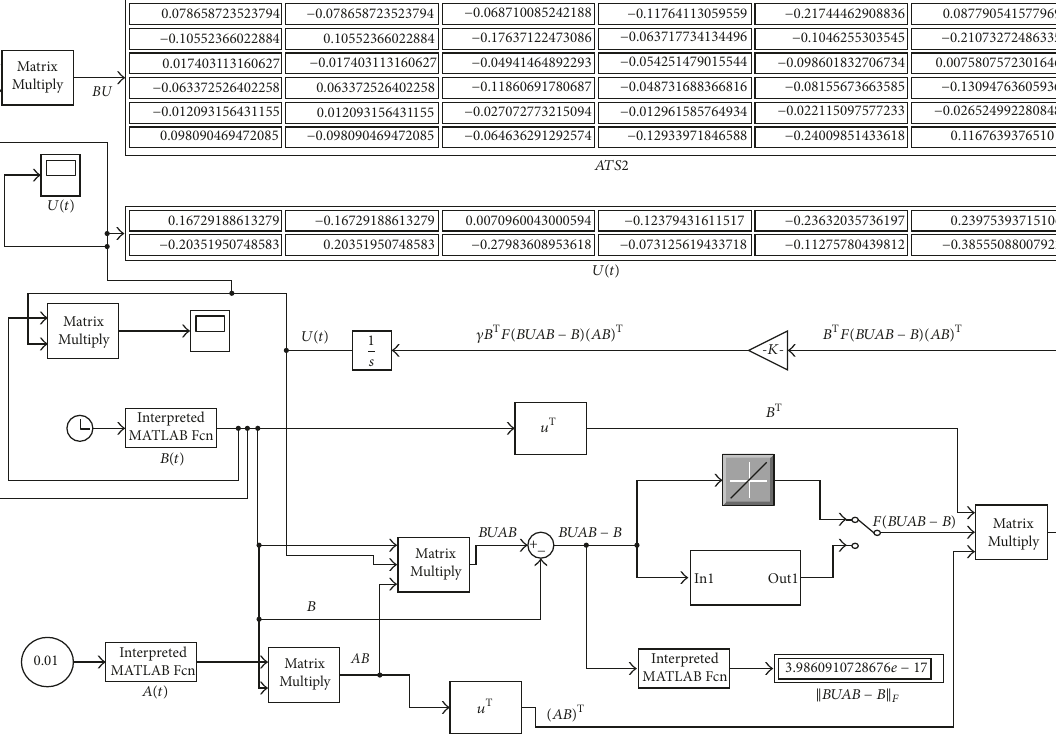
Figure 5: Simulink implementation of the GNN model for computing 𝐵𝑈𝐴𝐵 = 𝐵 , 𝑋 = 𝐵𝑈 ∈ 𝐴{2} R (퐵),∗ .